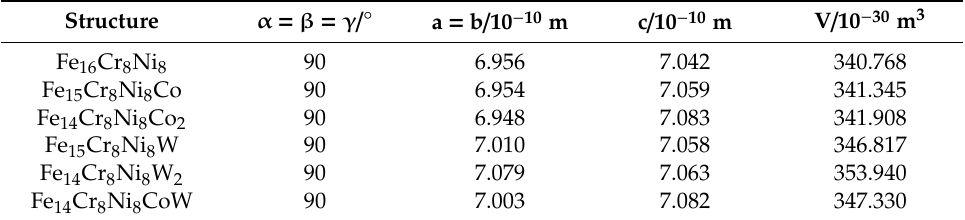
Table 1. Calculated structural constants of di ff erent systems after optimization.